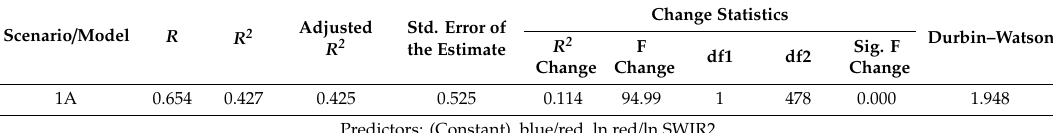
Table 7. Regression analysis statistics and model summary among reflectance values and log chlorophyll- a concentrations (dependent variable).